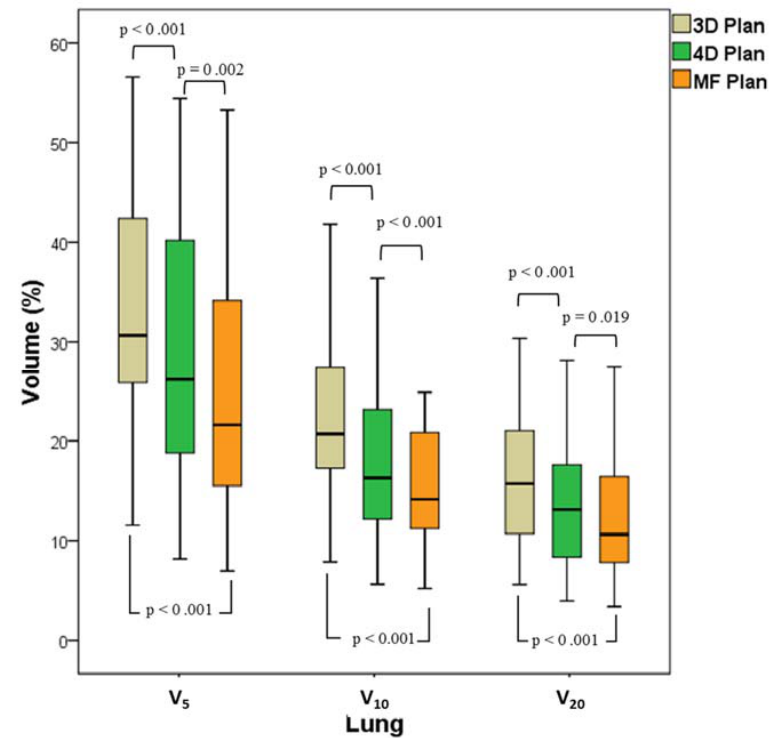
Figure 4. Box plot of the relative volume of the lung receiving a dose above 5 (V 5 ), 10 (V 10 ), and 20 (V 20 ) Gy for the three treatment plans.